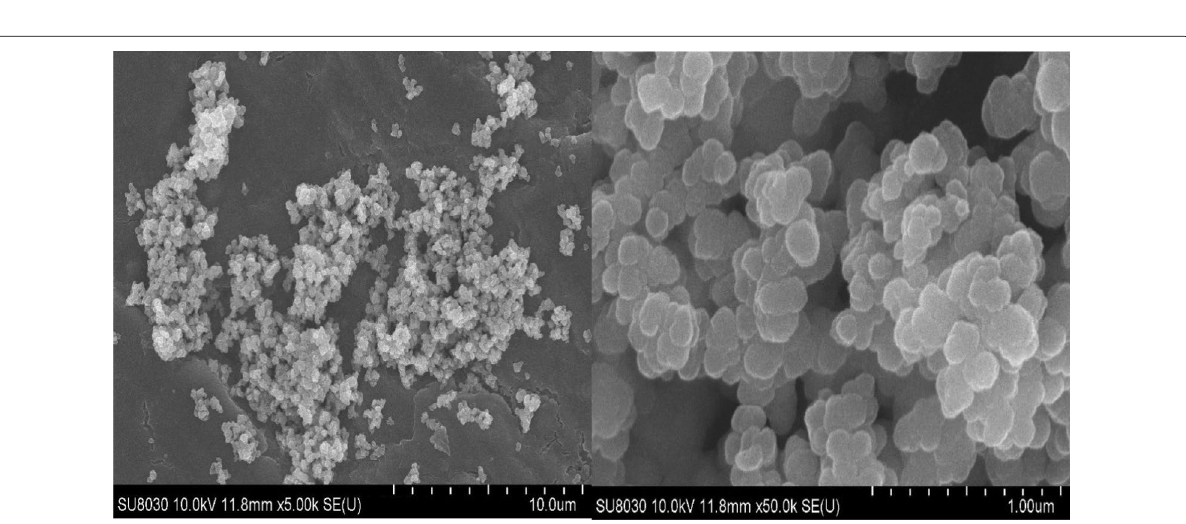
Fig. 4 SEM images of the